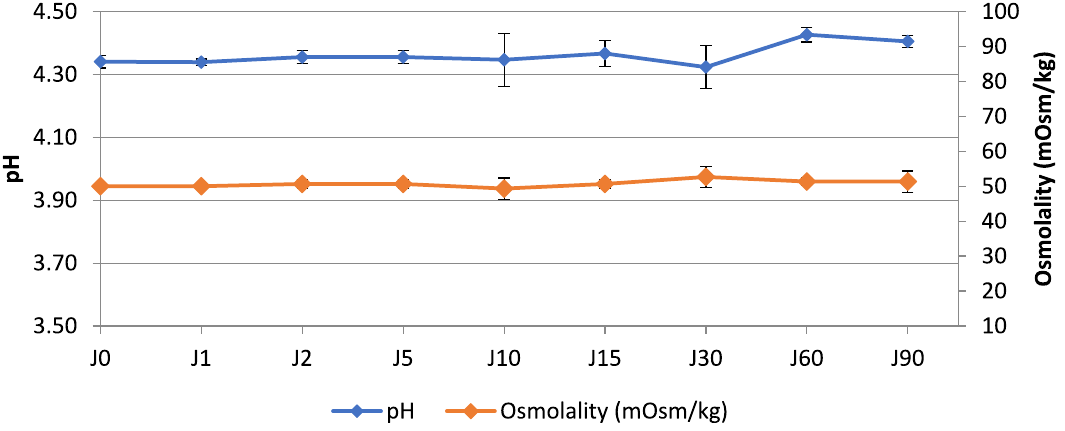
Figure 7: pH and osmolality modifications of amiodarone oral suspension over 90 days. Values are expressed as mean ± standard deviation.